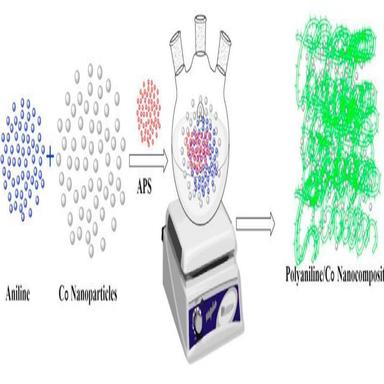
Schematic representation of the synthesis of Polyaniline/Cu nanocomposite.